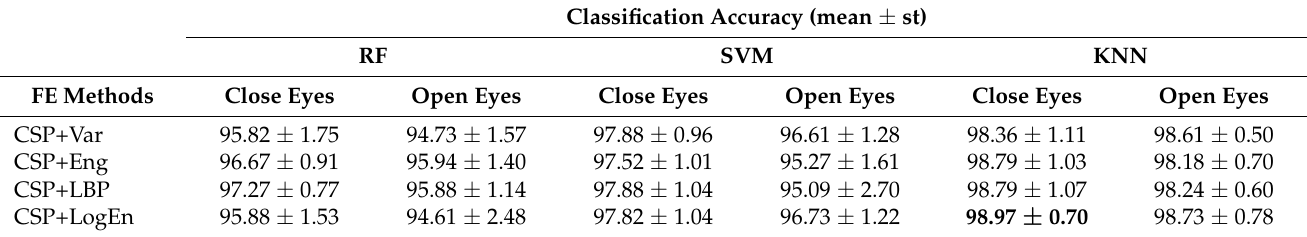
Table 15. Classification results of off–PD vs. on–PD (UNM dataset).